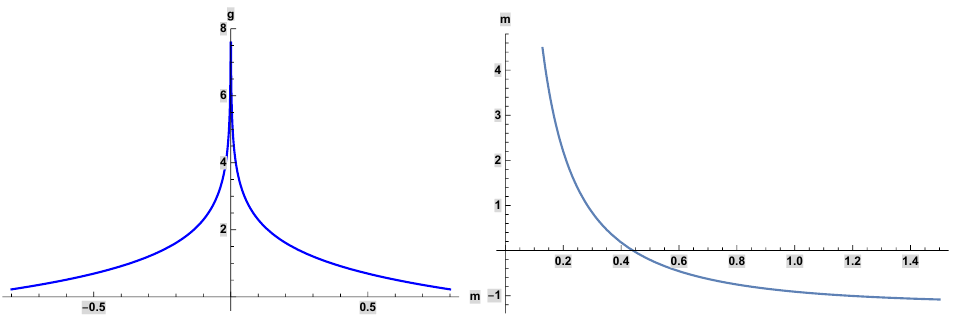
Figure 2: Left: Fisher information metric (50) for the 1d free fermion theory cor- responding to the 2d classical Ising model. Note that the metric obtained via the = 0. Right: plot of the mass mapping in [ 50 ] is only valid near the critical point m c (52) as a function of β = β J = β K , from which we see that the free fermion mass vanishes precisely at the critical temperature (47), corresponding to the phase tran- sition in the 2d model where one expects to find a conformal field theory. The mass also takes opposite signs on either side of the critical line in fig. 1 that matches the direction of divergence in the 2d curvature, i.e., we find m > 0 on the side nearer the origin and m < 0 on the side nearer β J = β K → ∞